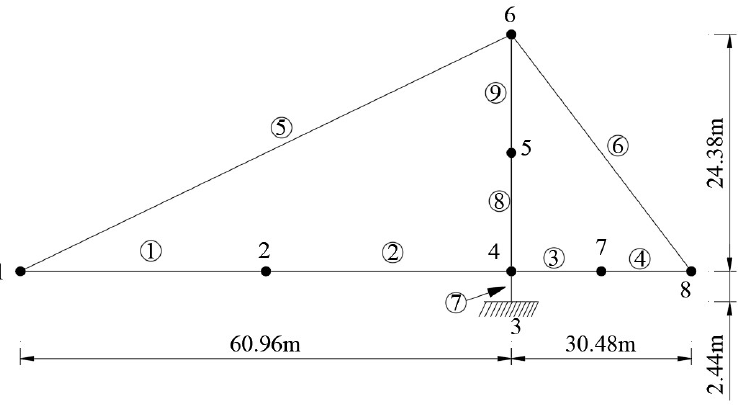
Figure 6. Calculation model diagram. Units in m. Table 3. Rigid arm position parameters.